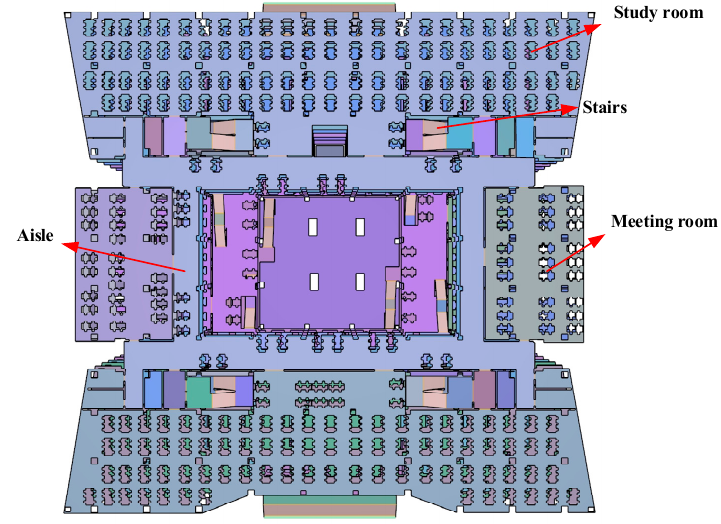
Figure 2. Building library internal model based on Revit.